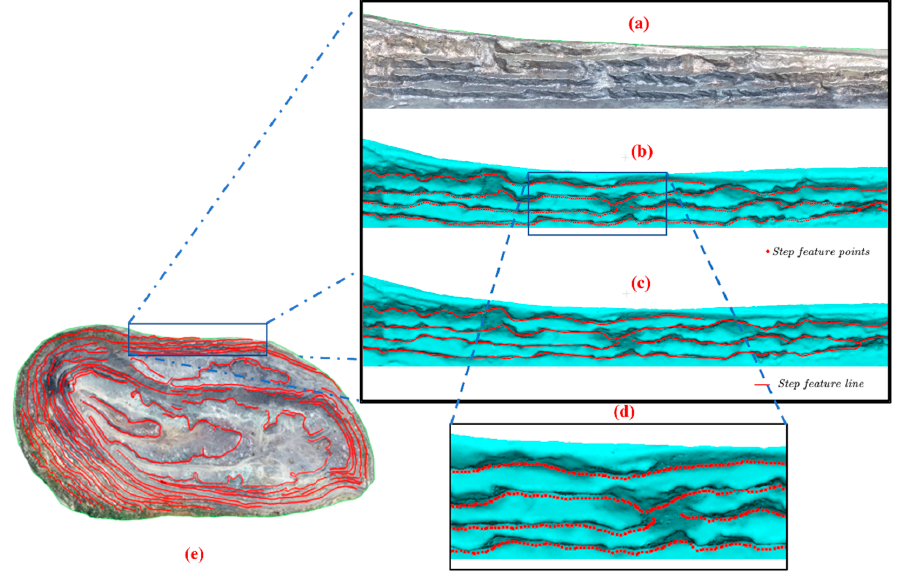
Figure 16. Step-feature-line reconstruction process: ( a ) part of the real model of the open-pit mine; ( b ) red points are the extracted step-feature points; ( c ) red line is the fitted step-feature line; ( d ) a zoomed-in view of the area, for the clear visibility of the step-feature points; ( e ) all the step-feature lines of the experimental area.